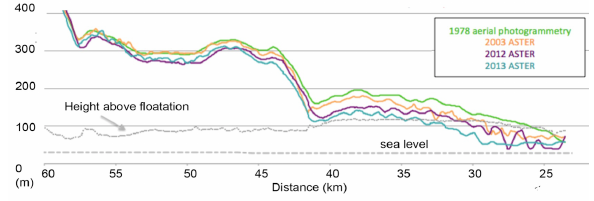
Figure 9. Elevation change along the central flow line from 1978 to 2013 from aerial photogrammetry DEM (1978) and corrected ASTER DEMs (2003, 2012, 2013.